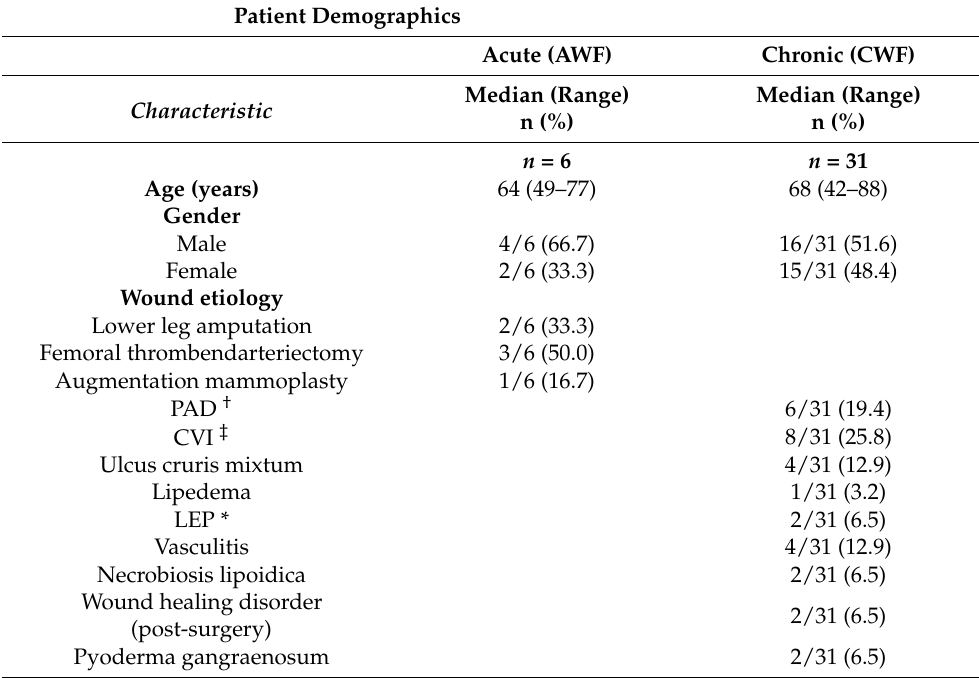
Table 2. Patient demographics of included wound exudate pools. Demographic data including age, gender, and wound etiology are summarized for acute wound exudate ( n = 6) and chronic wound exudate pools ( n =